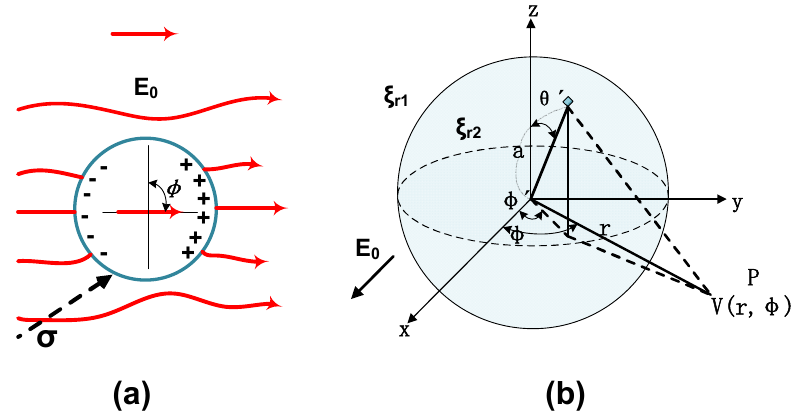
Figure 15. ( a ) Dipole electric charge and electric line of force distributions near spherical dielectric induced by an electric field E 0 , ( b ) The spherical dielectric is present in the base dielectric material.